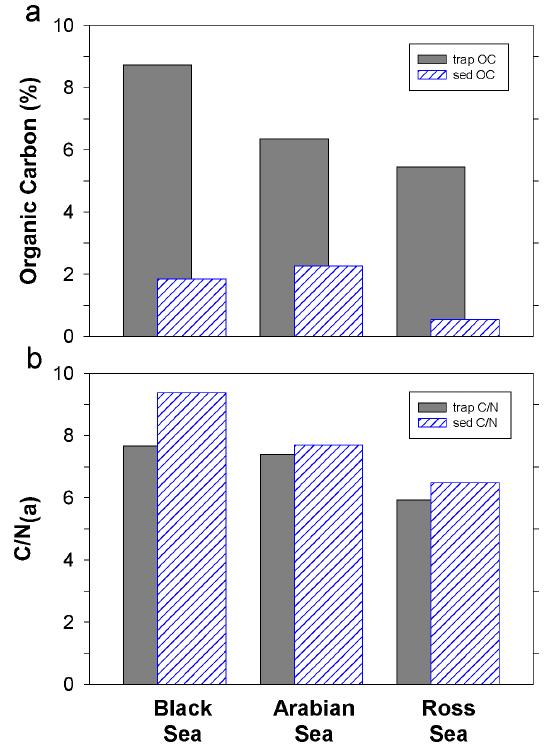
Figure 3. (a) Organic carbon (%OC) and (b) C/N ( a ) for bulk trap and